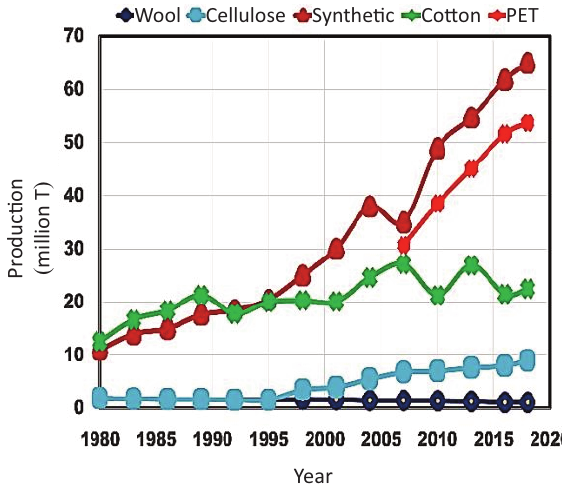
Fig. 1. Yearly quantity of world fibre production.